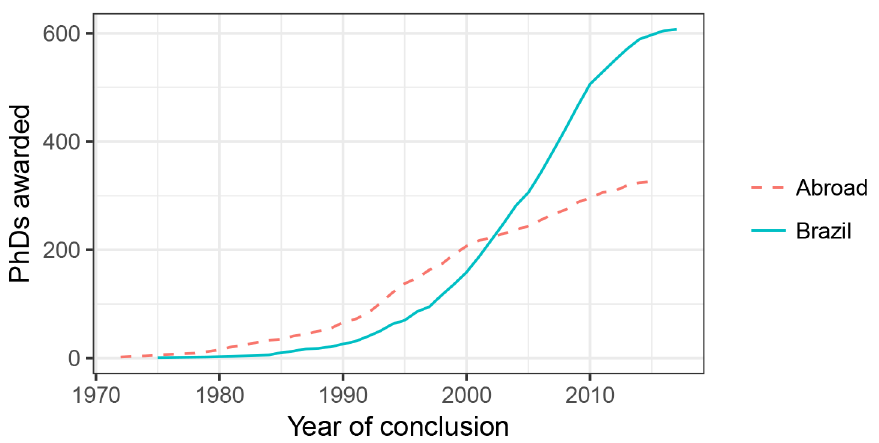
Figure 1 - Origin of PhDs for faculties working in Computer Science PhD programmes according to data from Brazilian Ministry of